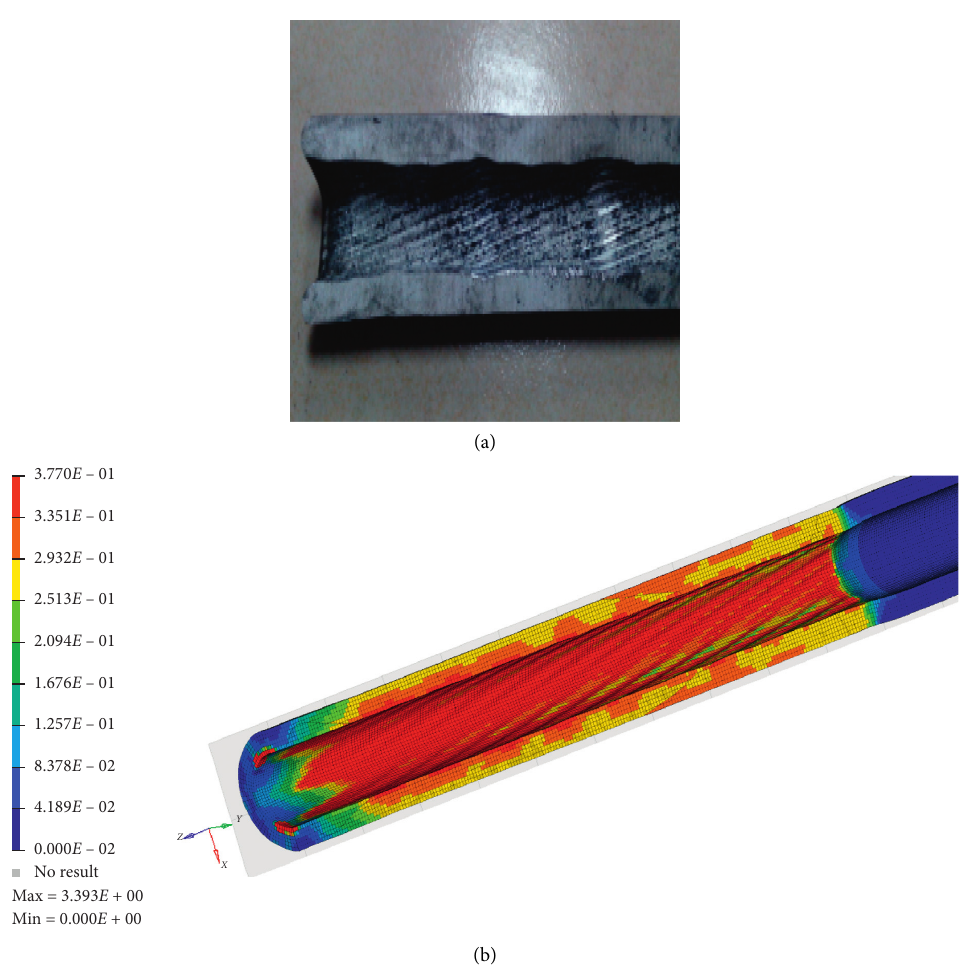
Figure 14: Crimping deformation between the aluminum pipe and the aluminum strand: (a) actual deformation; (b) finite element simulation of